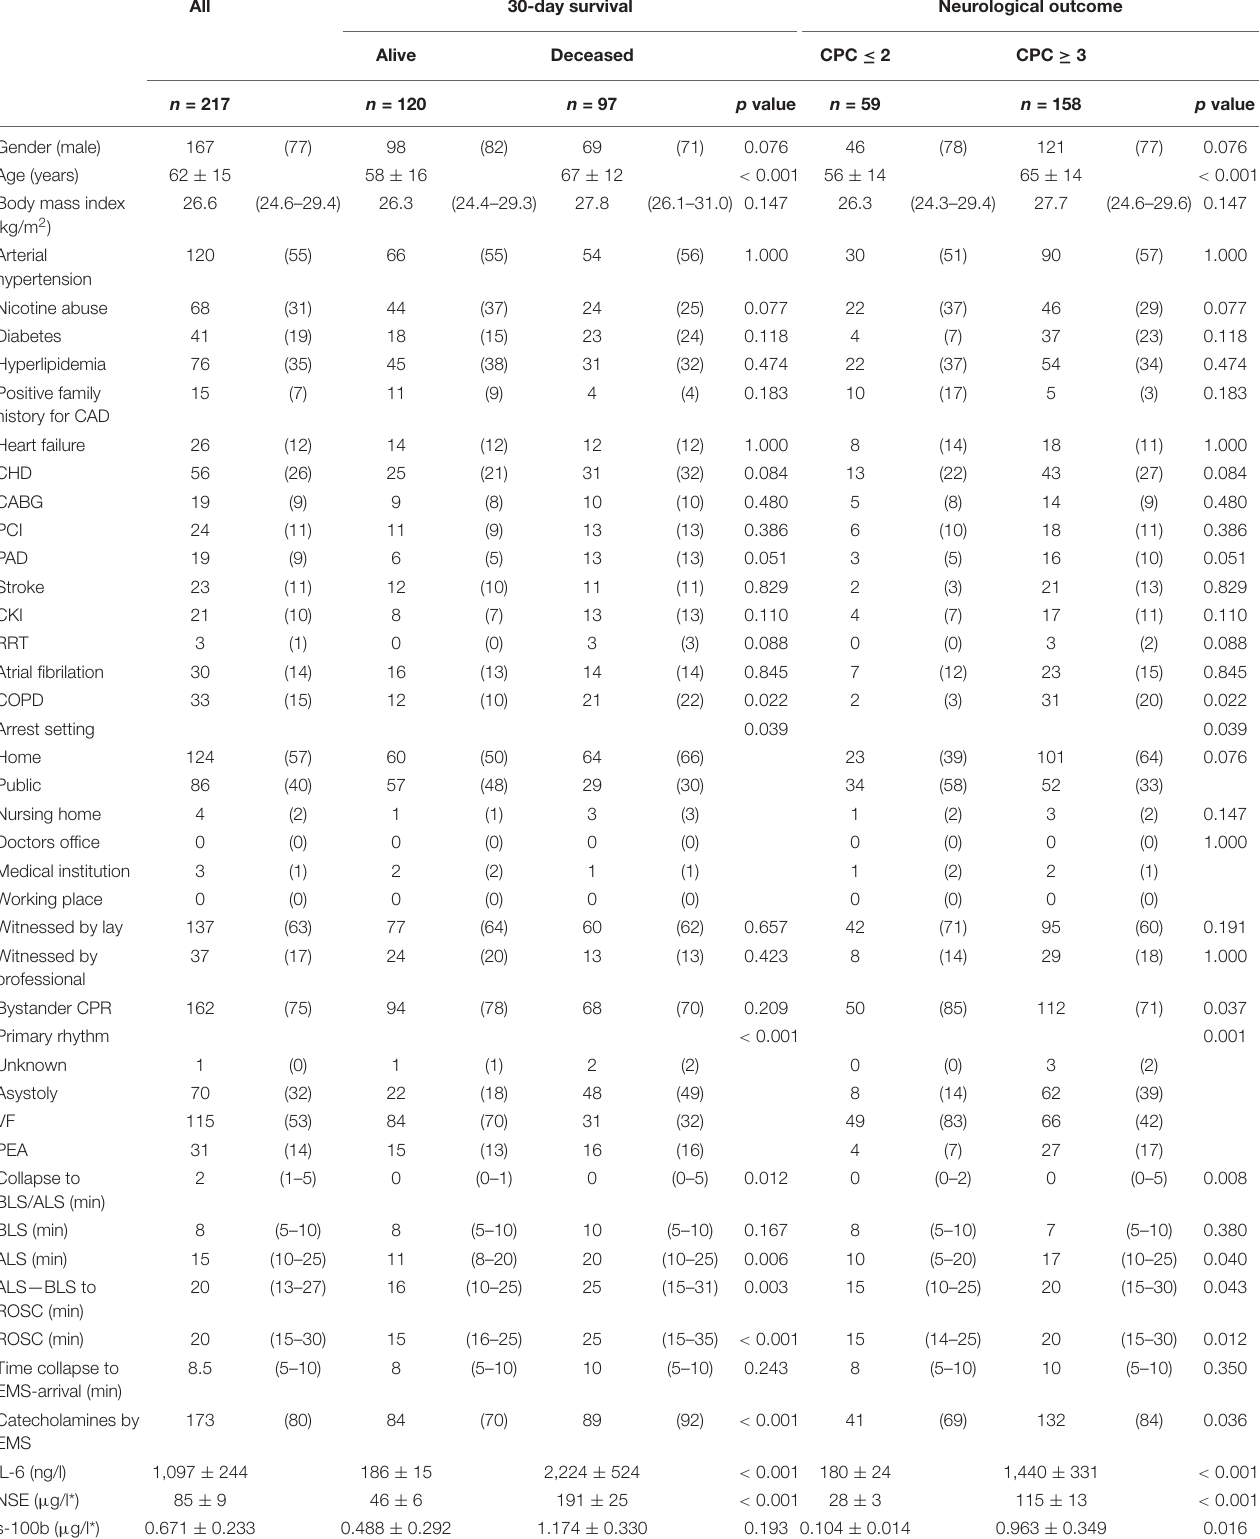
TABLE 1 | Baseline characteristics and distribution according to 30-day survival and neurological outcome during first 6 month. All 30-day survival Neurological